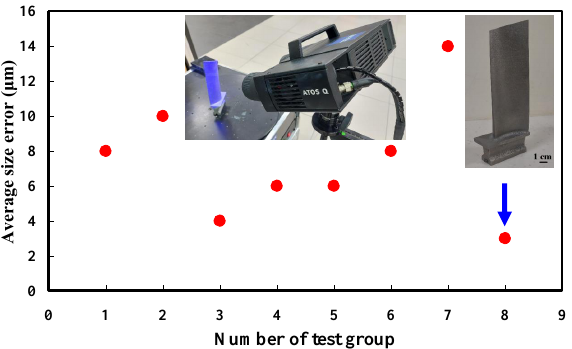
Figure 7. Average size error of the eight test groups compared to conventional method for the as- cast part.